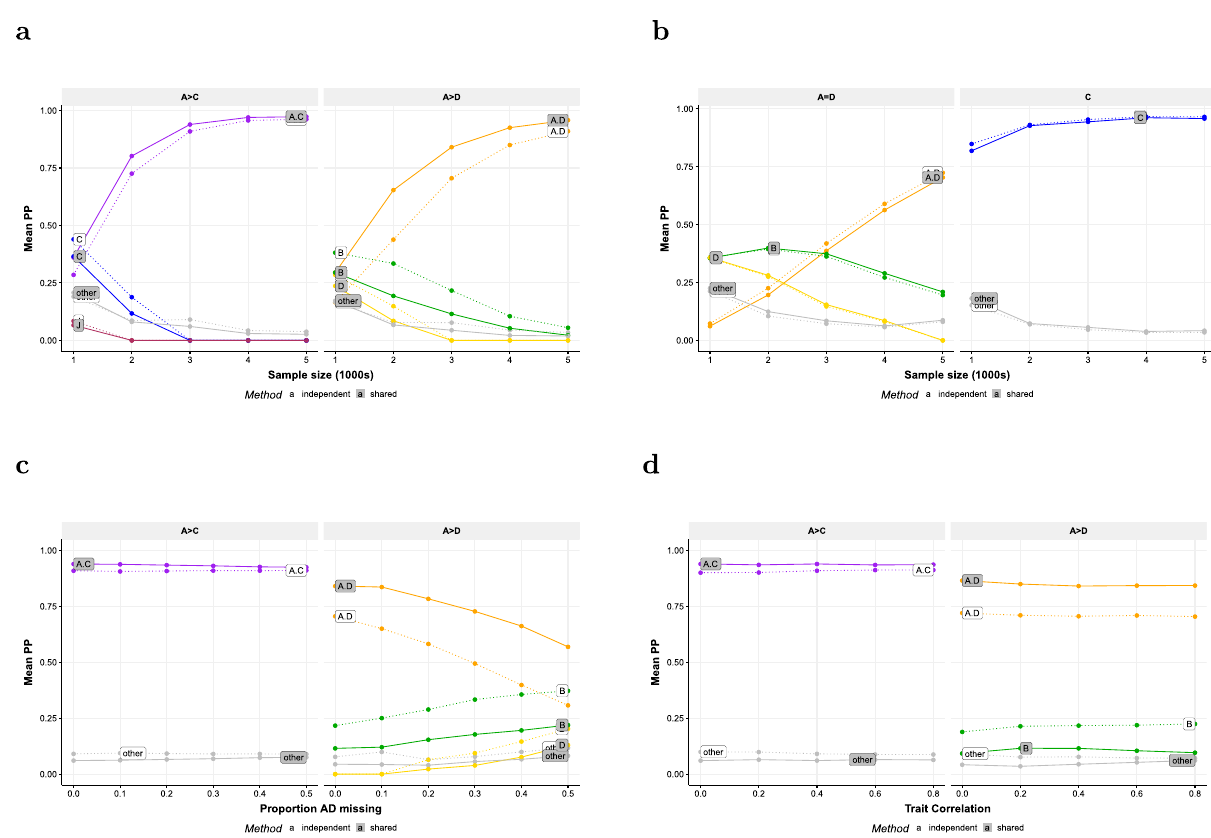
Fig. 2 Comparison of fi ne-mapping from fl ashfm and single-trait analyses. When traits share a causal variant, fl ashfm has higher accuracy than single- trait fi nemapping, regardless of amount of missing data and trait correlation; both methods have similar accuracy when there are no shared causal variants. Causal variants were simulated for two traits with models de fi ned by SNP groups from the IL2RA region. We vary sample size when the traits share a causal variant ( a ) and do not share any causal variants ( b ). At fi xed sample size N = 3000, we vary the proportion of missing data for one trait ( c ) and vary the trait correlation ( d ). In a , c and d Trait 1 has causal variants A + C, while trait 2 has A + D causal variants, both A causal variants with the same effect size: β A = log (1.4) and β D = β C = log (1.25). In a and b there are no missing data and the sample size varies from 1000 to 5000. In c the sample size is fi xed at 3000 and the proportion of missing data for trait A + D varies from 0 to 0.5. In d the sample size is fi xed as 3000 and the correlation between traits varies. In b Trait 1 has causal variants A + D with β A = log (1.25) and β D = (1.25), while trait 2 has a single causal variant C with β C = log (1.25). Results are based on 300 replications. Source data are provided in Supplementary Data 1, Supplementary Data 1.2, 1.3, 1.6,